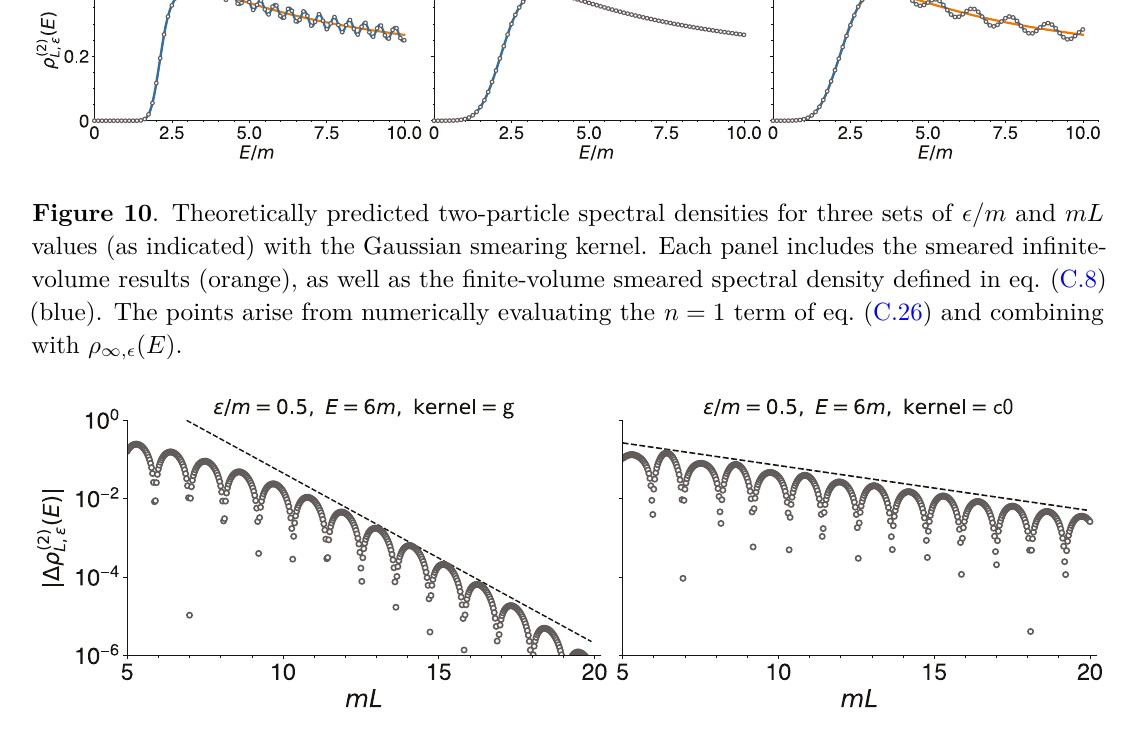
Figure 11 . Plots of the finite-volume residue vs. L for the Gaussian kernel ( g , left) and Cauchy kernel ( c0 , right), determined using eq. (C.26). The dashed lines give the predicted e − µL scaling for each (with a pre-factor chosen to position the curve for ease of comparison); µ = m for the Gaussian and µ = 0 . 265 m for the Cauchy, slightly exceeding (cid:15)/ 2 as given by eq. (C.25). The Gaussian data includes only the n = 1 term of eq. (C.26) while the Cauchy includes the sum over the n = 1 , 2 , 3 terms, i.e. all terms that fall-off slower than e − mL